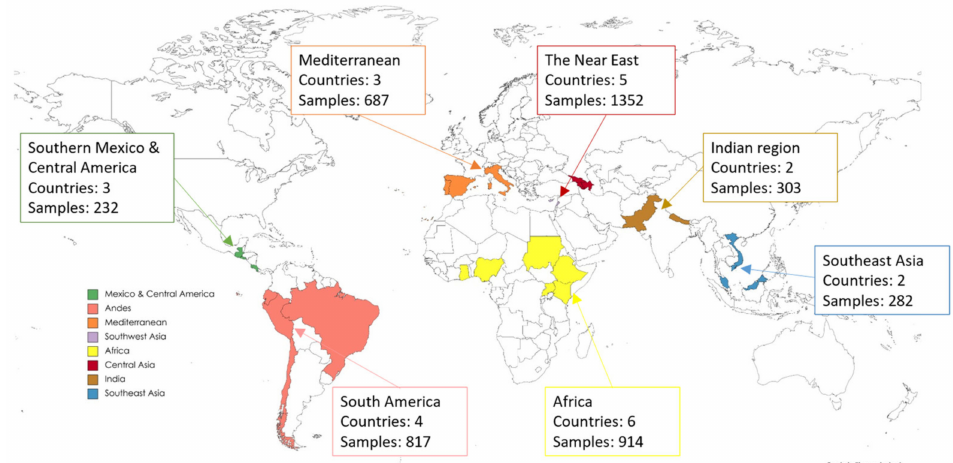
Figure 2. Countries and number of samples collected by the Adapting Agriculture to Climate Change Project (CWR Project) in seven of Vavilov’s centers of origin [46]. Map created using MapChart.net.